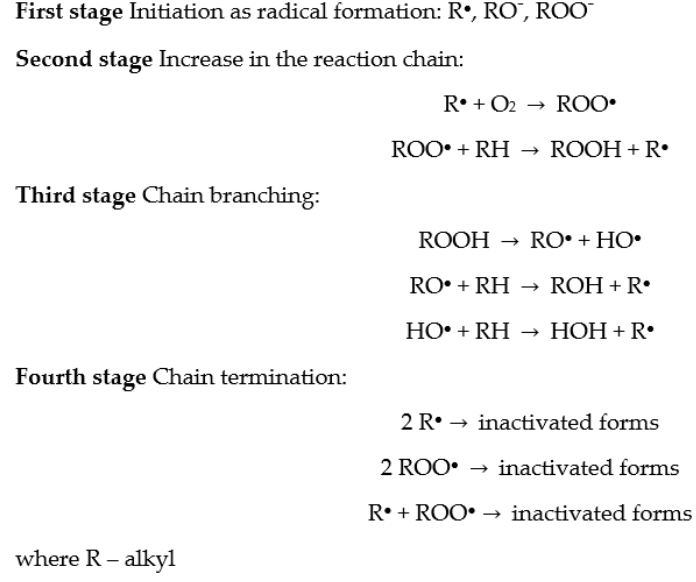
Scheme 1. The general mechanism of polymer degradation.